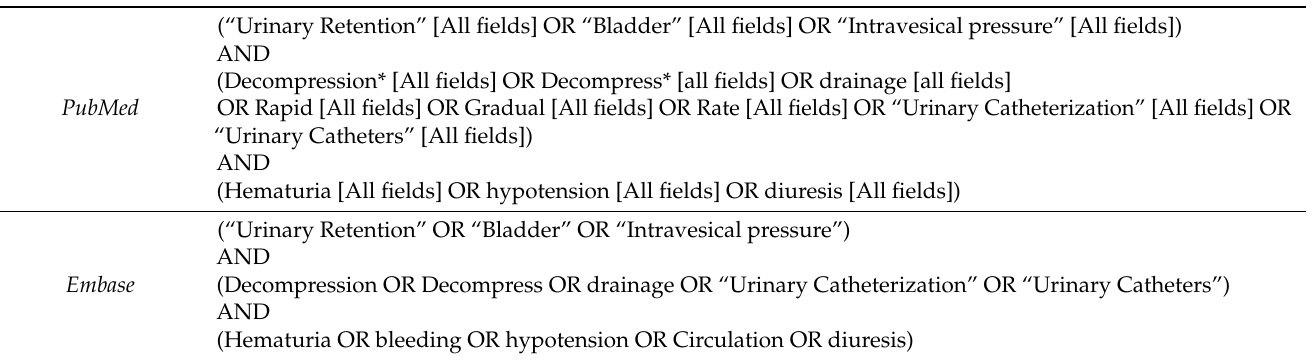
Table 1. Search strategy